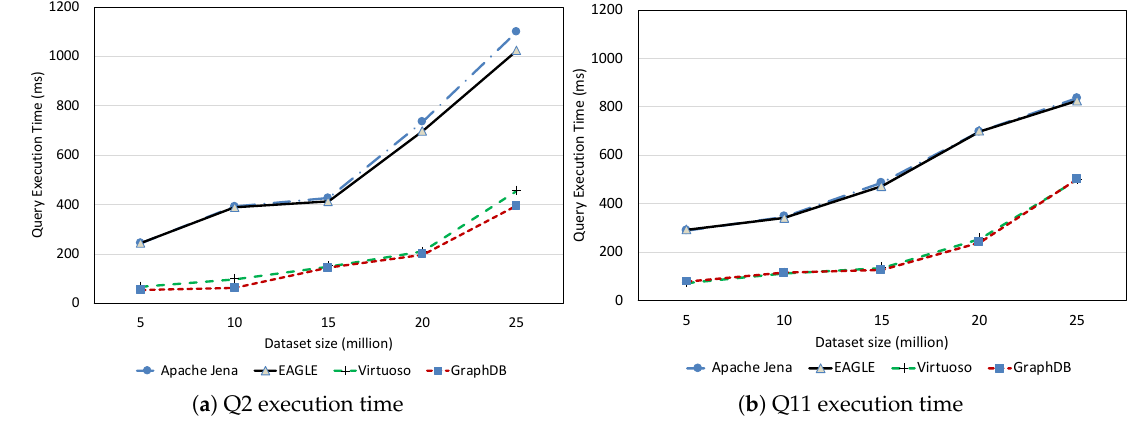
Figure 19. Non spatio–temporal query execution time with respect to dataset size.